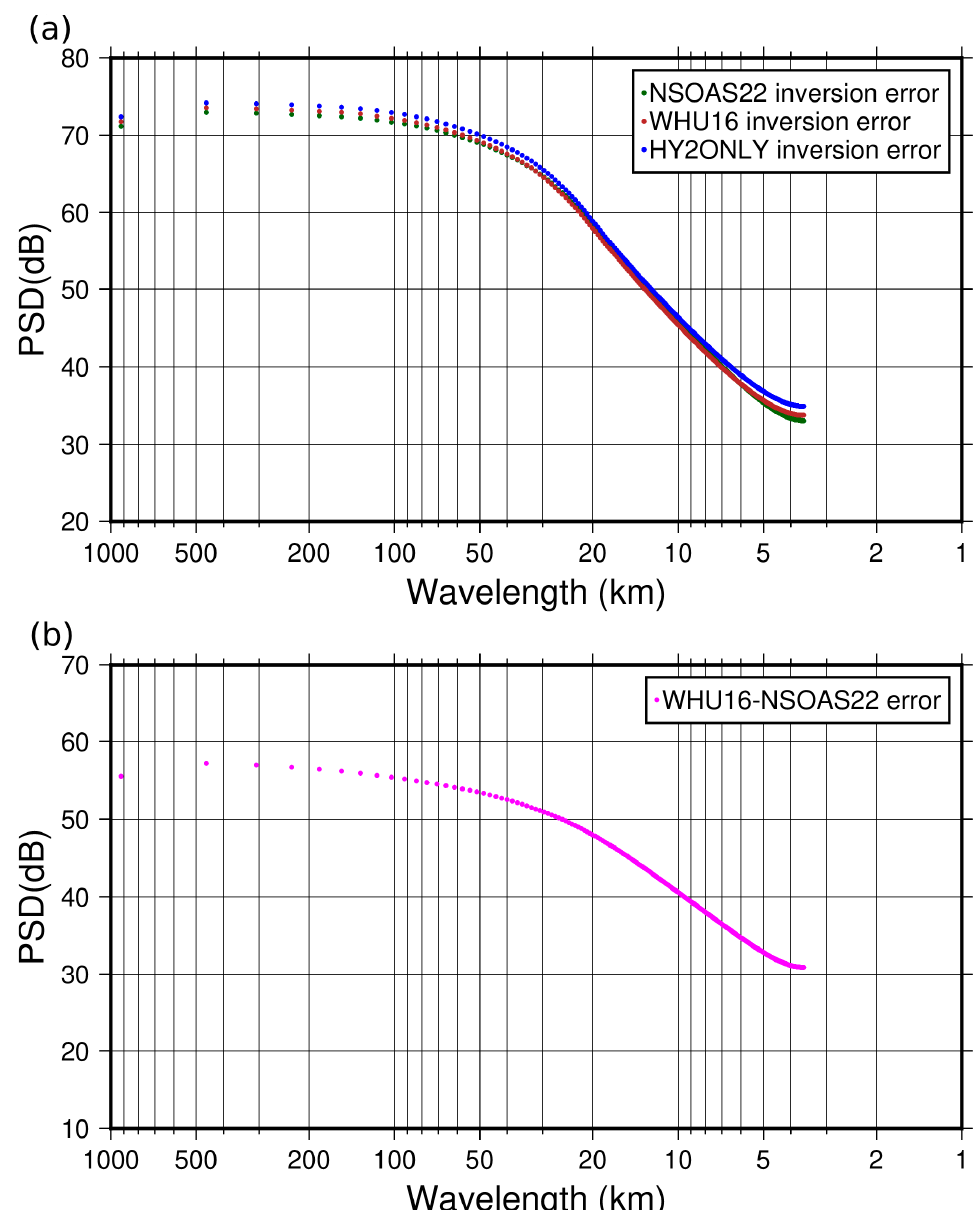
Figure 12. ( a ) Error PSD; and ( b ) PSD of the difference between absolute error of WHU16_BAT and NSOAS22_BAT.